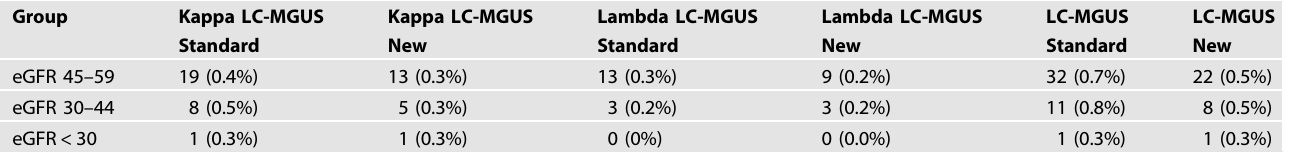
Table 4. Comparison of LC-MGUS rates using standard reference intervals and new reference intervals (FLC ratio and kappa, and lambda FLCs) in participants with eGFR < 60 mL/min/1.73 m 2 .